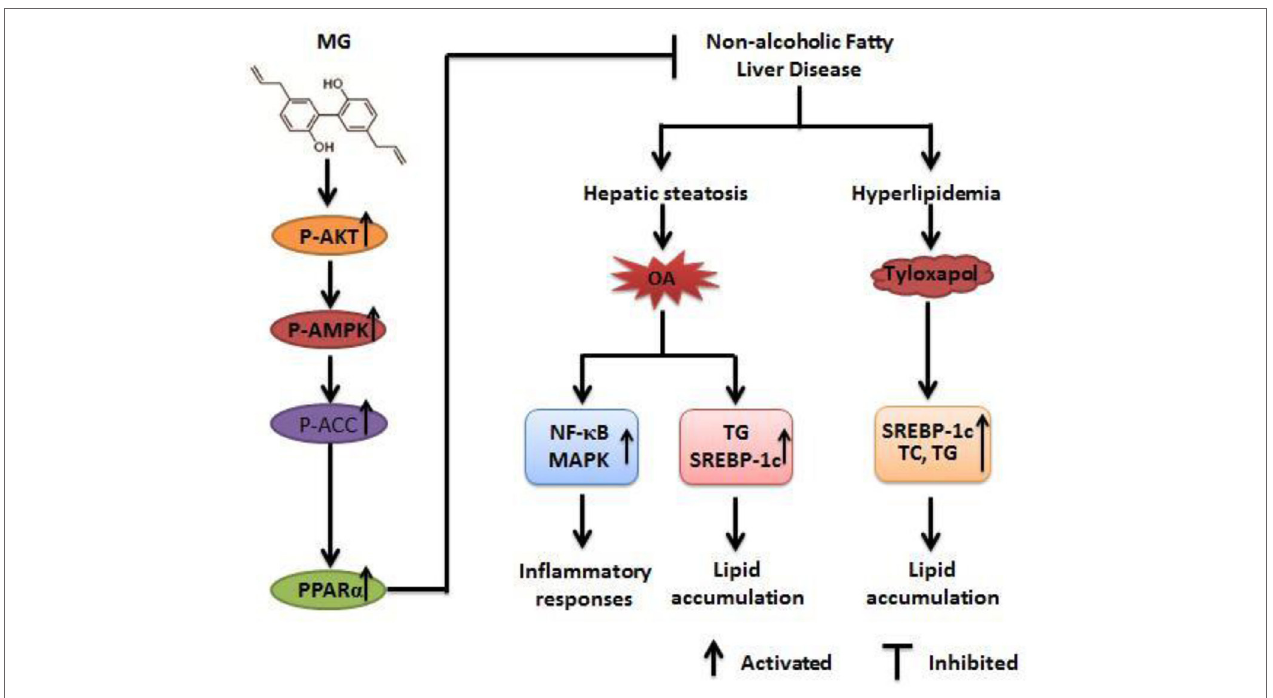
FigUre 10 | Magnolol (MG)-activated peroxisome proliferator-activated receptor α (PPAR α ) expression protects against inflammatory responses and lipid accumulation in oleic acid (OA)-induced steatosis of HepG2 cells and in tyloxapol-induced hyperlipidemia mice. MG can induce AMPK, AKT, and acetyl-CoA carboxylase (ACC) activation, which contribute to upregulation of PPAR α expression and leads to anti-steatosis and antihyperlipidemia effects that are dependent on attenuating the induction of sterol regulatory element-binding protein 1c (SREBP-1c) protein expression. Furthermore, MG reduces OA-induced reactive oxygen species and TNF- α overproduction by inhibiting the activation of the nuclear factor-kappa B (NF- κ B) and mitogen-activated protein kinase (MAPK) signaling pathways. These pathways play significant roles in repressing lipid accumulation and inflammatory responses to alleviate steatosis and